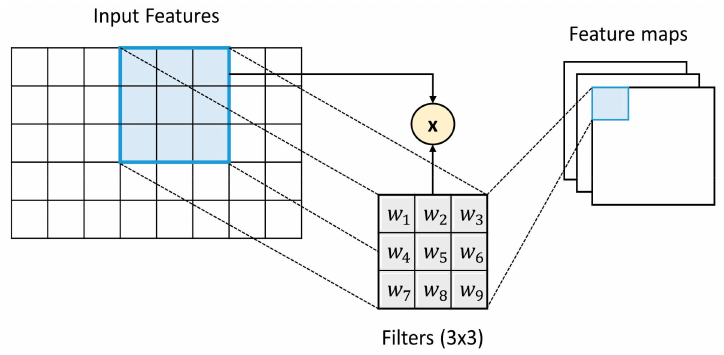
Figure 3. Feature maps generated from the convolutional operation.